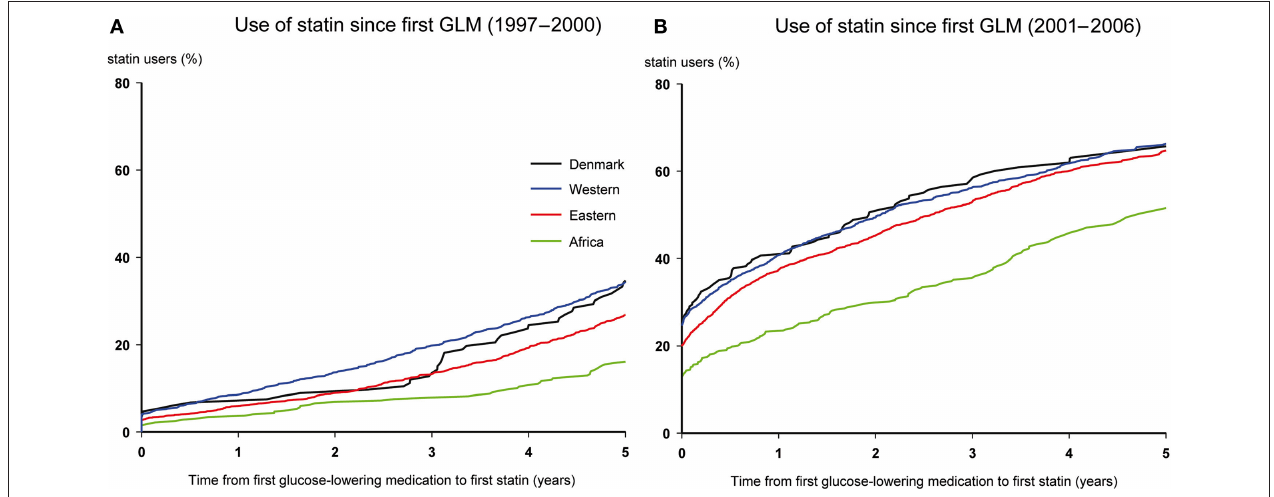
FiguRe 2 | Statin initiation among glucose-lowering medicine users 1997–2006. Kaplan–Meier plots over elapsed time from first glucose-lowering medicine (GLM) claim until the first statin claim over a 5-year follow-up period since 1997 (A) and 2001 (B) respectively.